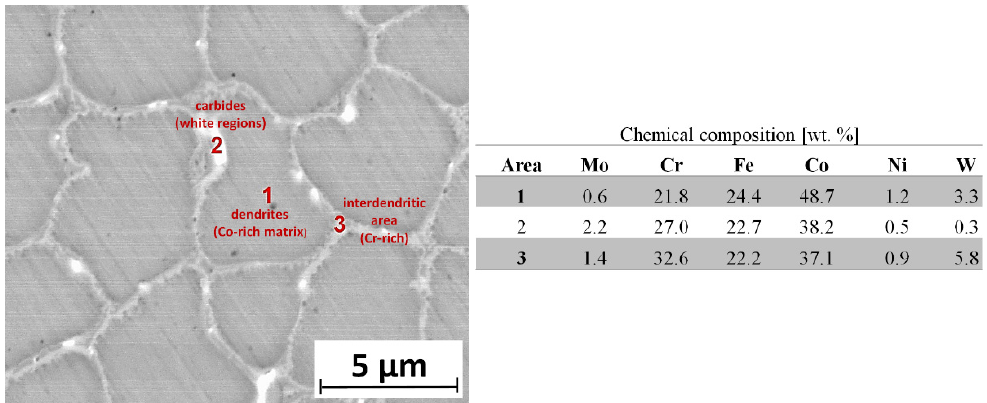
Figure 4. The results of the EDS linear chemical composition analysis of Co-6 coating specimen #4 (according to Table 1).